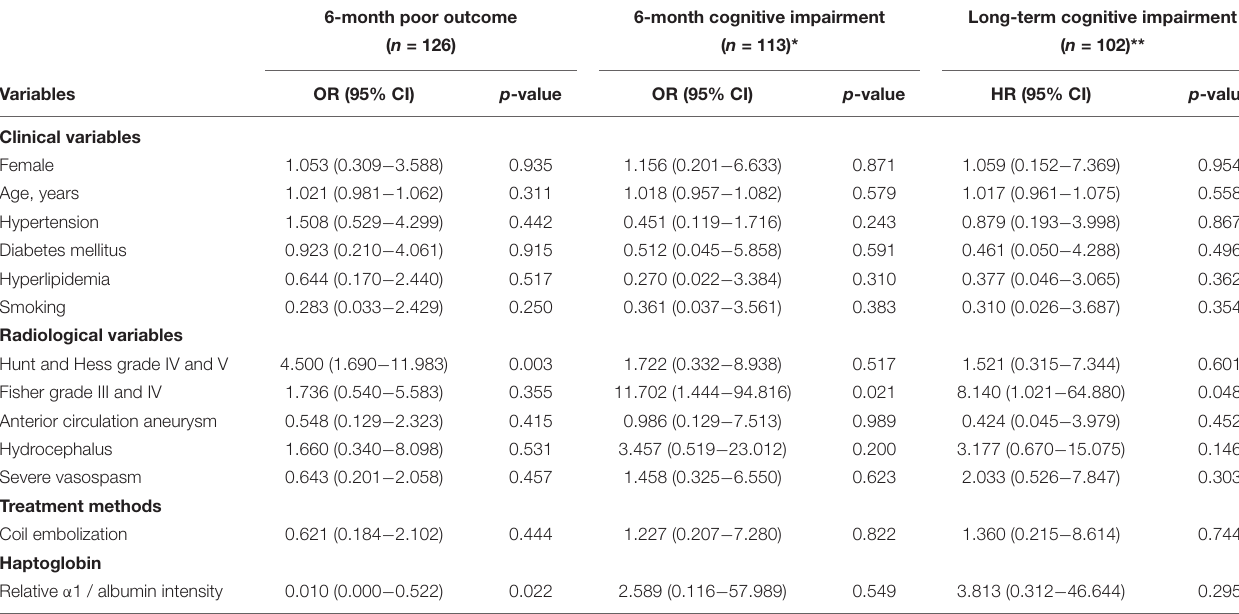
TABLE 4 | Multivariable logistic regression analysis of variables associated with poor neurological outcome and cognitive impairment at 6 months, and Cox proportional-hazards regression analysis of long-term cognitive impairment during follow-up of patients with subarachnoid hemorrhage expressing haptoglobin 2-1. 6-month poor outcome 6-month cognitive